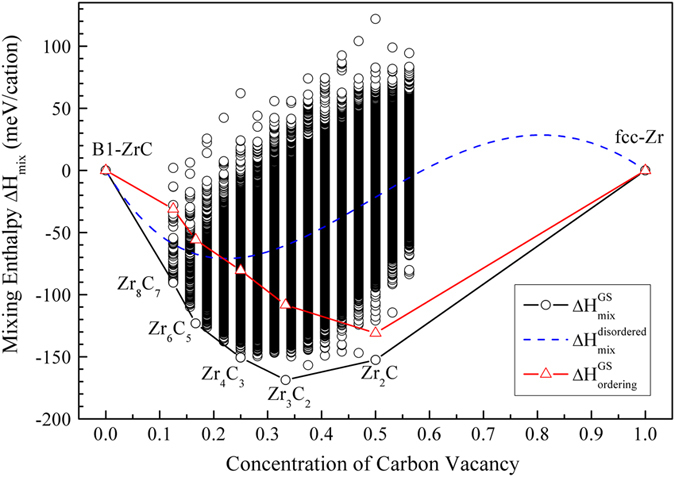
Mixing enthalpies (B1-ZrC and f.c.c. Zr as reference states) of ordered (the circles) and disordered (the dashed line,  vacancy configurations with various compositions.The ground states are predicted as Zr8C7 (P4332), Zr6C5 (C2/m), Zr4C3 (C2/m), Zr3C2 (Fddd) and Zr2C (Fd-3m) ordered phases.